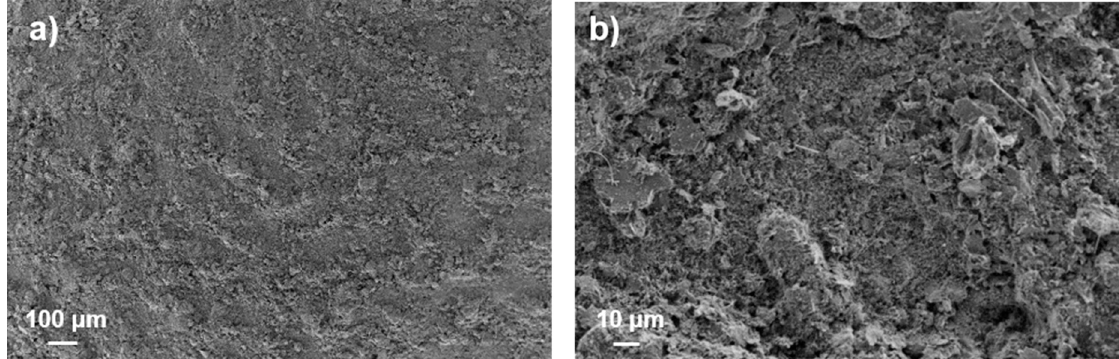
Figure 4. SEM images of the 6L anode microstructure obtained by printing ball-milled ink for three